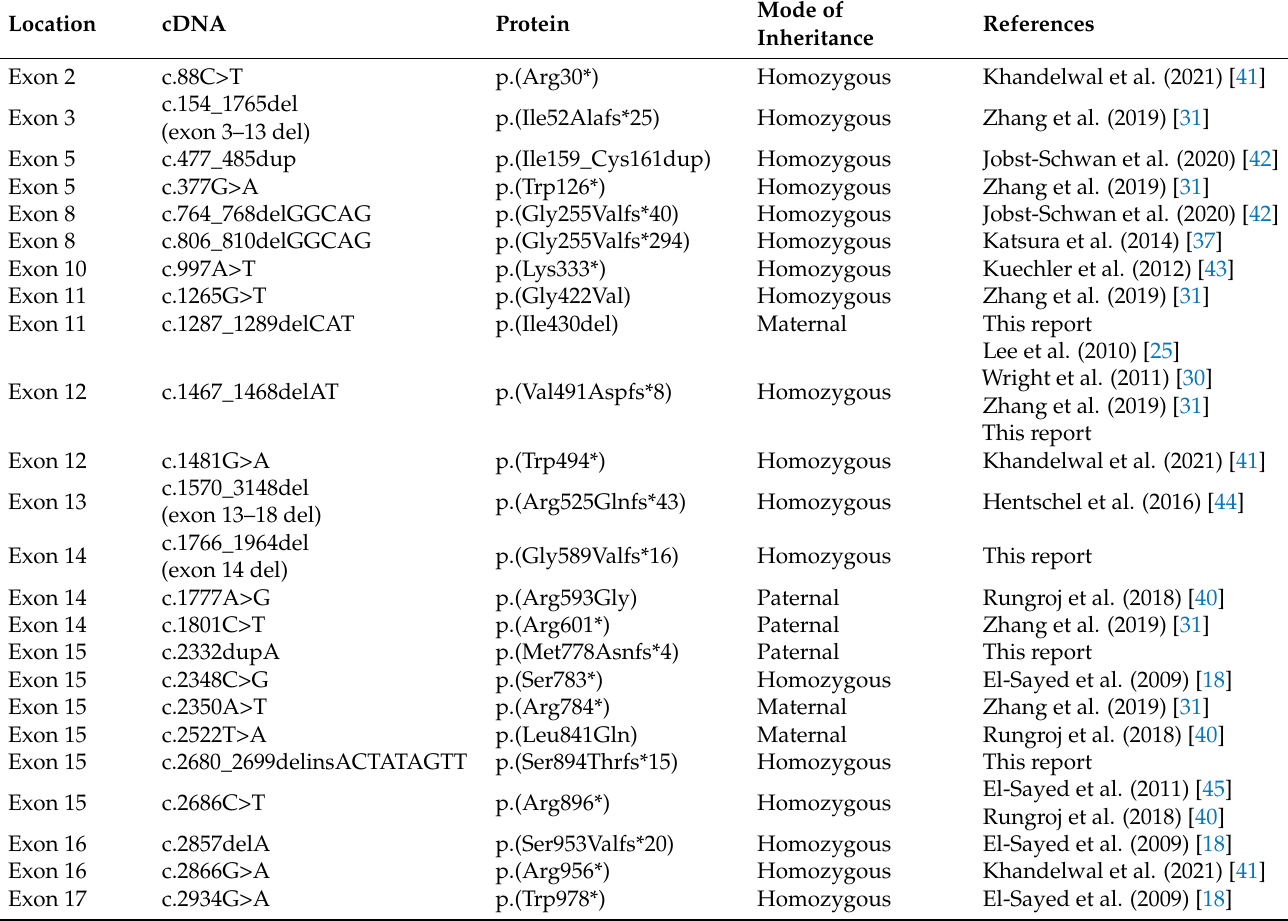
Table 2. Disease-causing mutations in WDR72